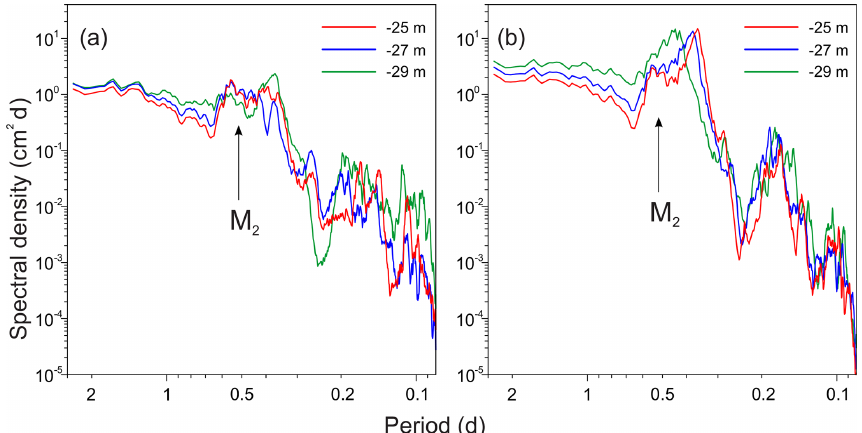
Figure 10. Sea level spectra for (a) Türkmenba¸sy Gulf and (b) Turkmen Bay at different MSL values for the Caspian